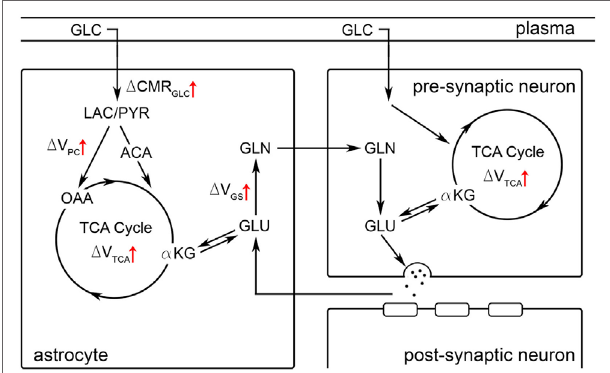
FigUre 8 | A schematic representation of the glutamatergic tripartite synapse is depicted. Black arrows illustrate relationships between molecular species. Red arrows illustrate enzymatic or metabolic reactions that are hypothesized to be upregulated during neural stimulation or cognitive task performance based on well-controlled preclinical studies which observed an increase in glutamate-glutamine cycling [e.g., Ref. (50)]. Net formation of glutamate during stimulation (i.e., as observed in 1 H fMRS studies) is hypothesized to be associated with elevated glucose (GLC) extraction and metabolism (CMR GLC ) (50). ACA, acetyl-CoA; α KG, α -ketoglutarate; CMR GLC , cerebral metabolic rate of glucose; GLC, glucose; GLN, glutamine; V GS , glutamine synthetase rate; GLU, glutamate; LAC, lactate; OAA, oxaloacetate; PYR, pyruvate; V PC , pyruvate carboxylation rate; V TCA , TCA cycle